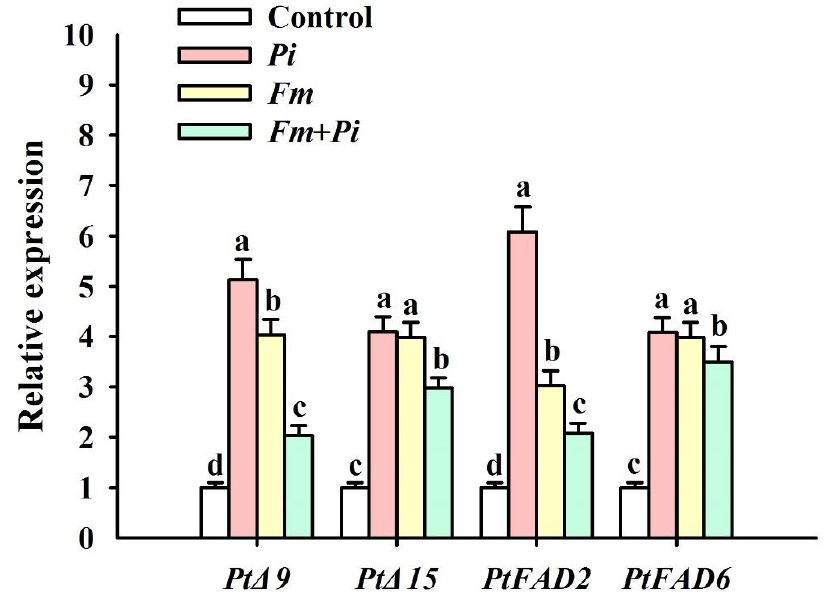
Figure 4. Effects of Piriformospora indica ( Pi ) and Funneliformis mosseae ( Fm ) singly and in combination on the relative expression levels of four FA desaturase genes in roots of trifoliate orange seedlings. Data (means ± SD, n = 3) followed by different letters above the bars indicate significant differences ( p < 0.05) between treatments.